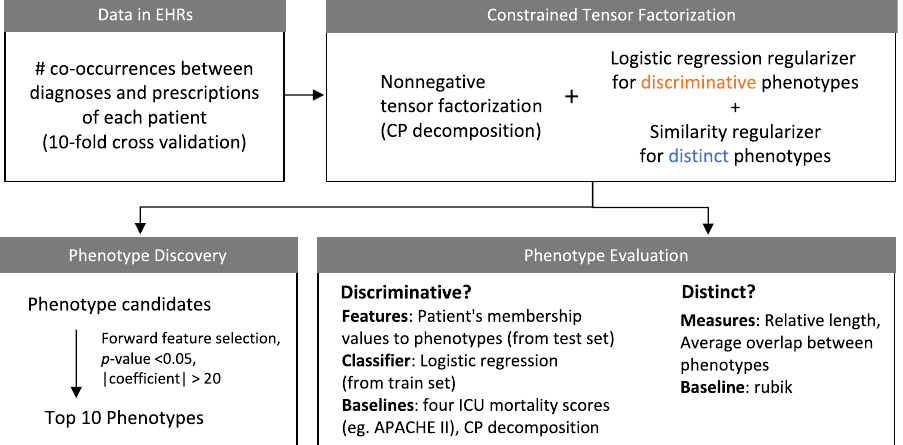
Figure 1. Workflow of our phenotyping method. We constructed a tensor using the number of co-occurrences between diagnoses and prescriptions of each patient in EHRs. We then decomposed the tensor using the proposed constrained tensor factorization that incorporates regularizers for discriminative and distinct phenotypes. We defined phenotype as a set of co-occurring diagnoses and prescriptions, which can be inferred using decomposed tensors, and evaluated their discriminative and distinct power. We also selected top 10 representative phenotypes and presented its meaning and